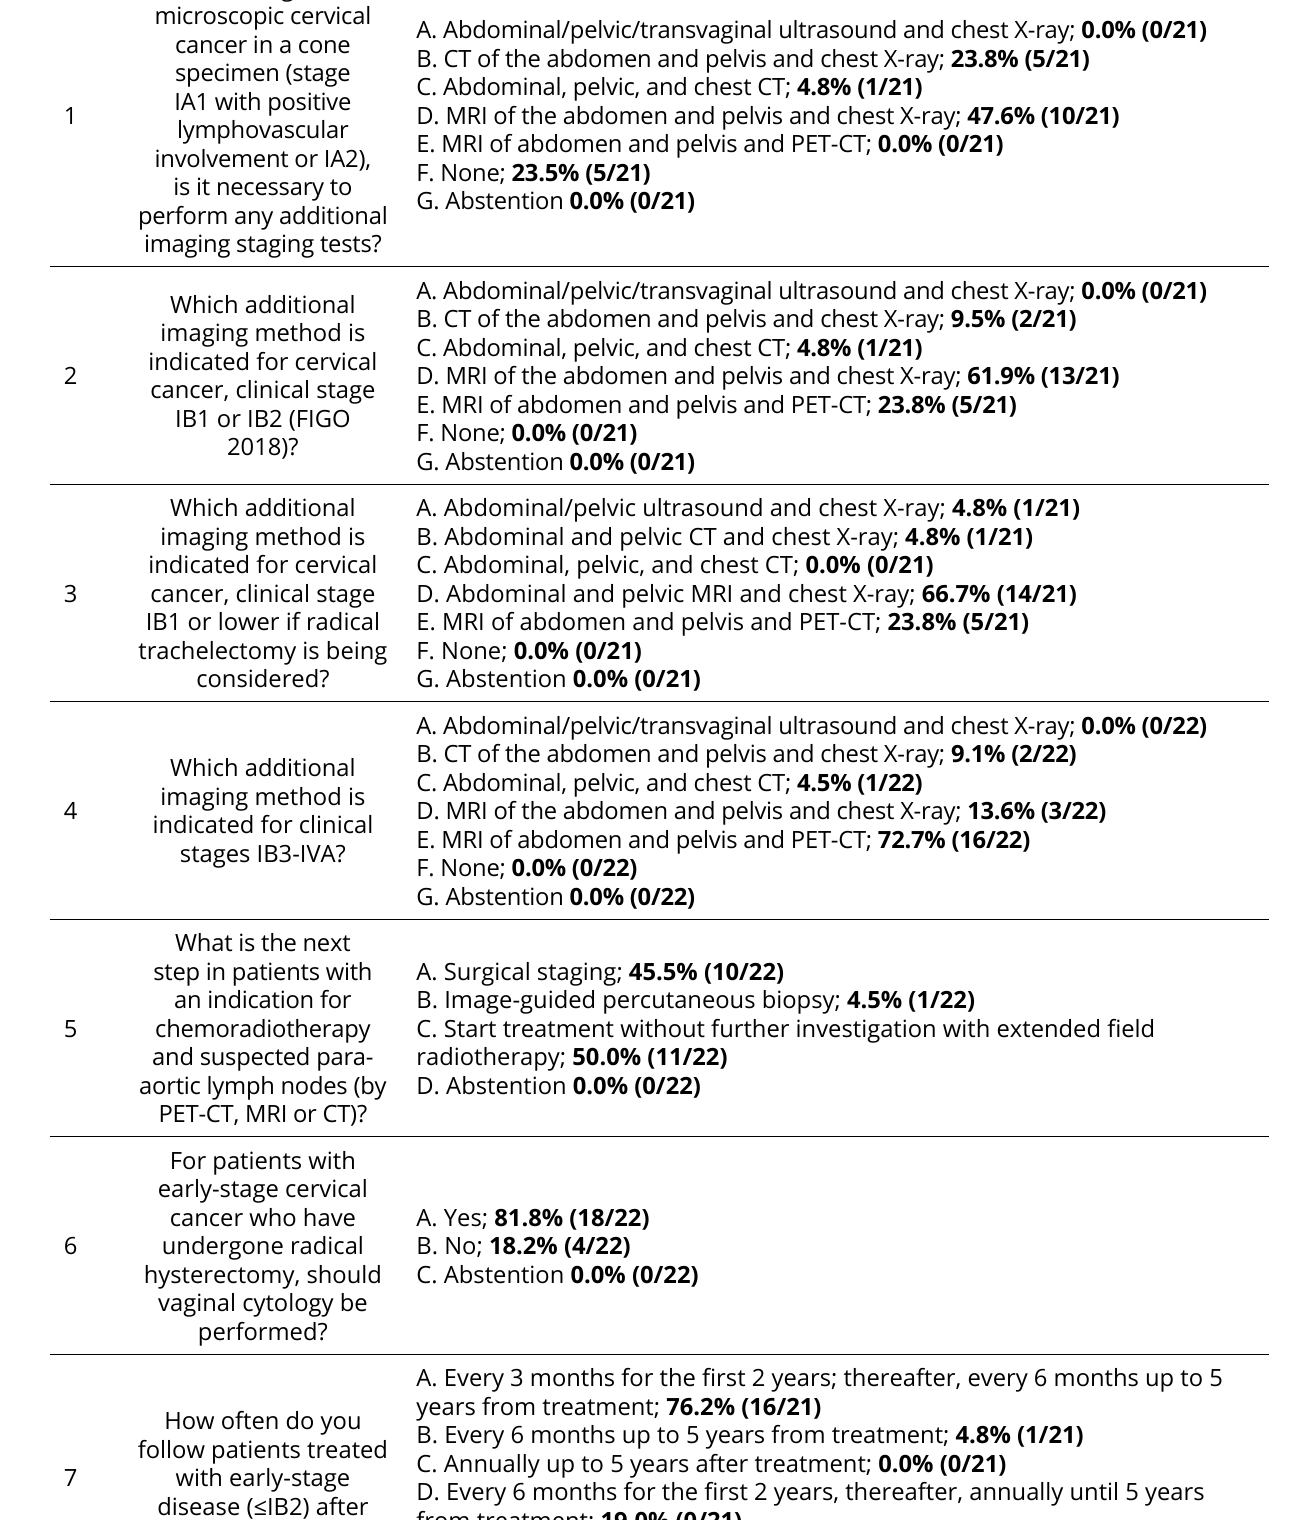
Supplementary Materials